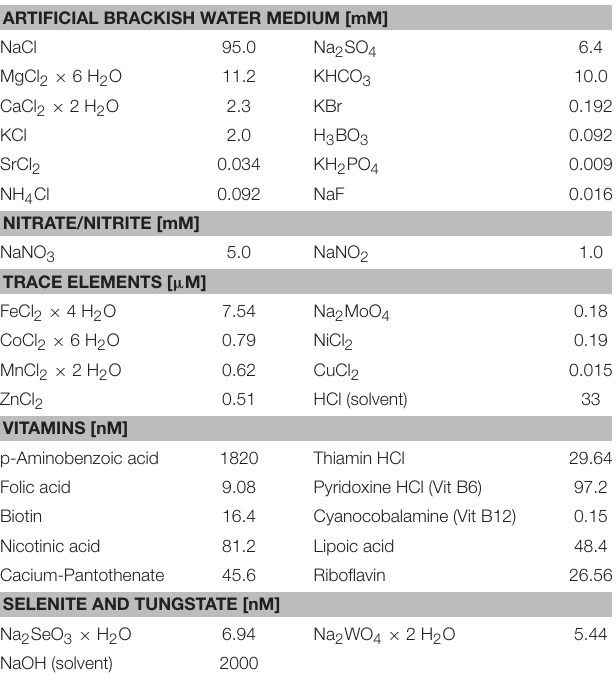
TABLE 1 | Compound concentrations of the nutrient